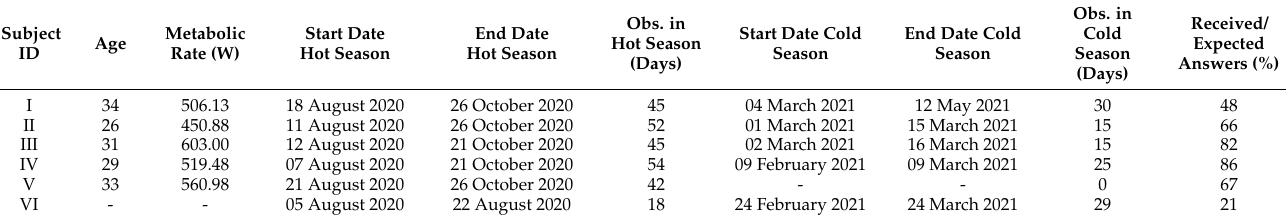
Table 2. Start and end date of data collection for each